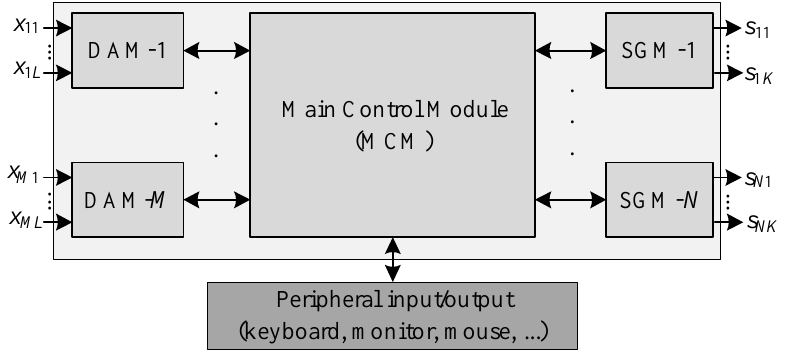
Figure 1. Physical architecture of the Real-Time Simulator for Dynamic Systems (RTSDS)